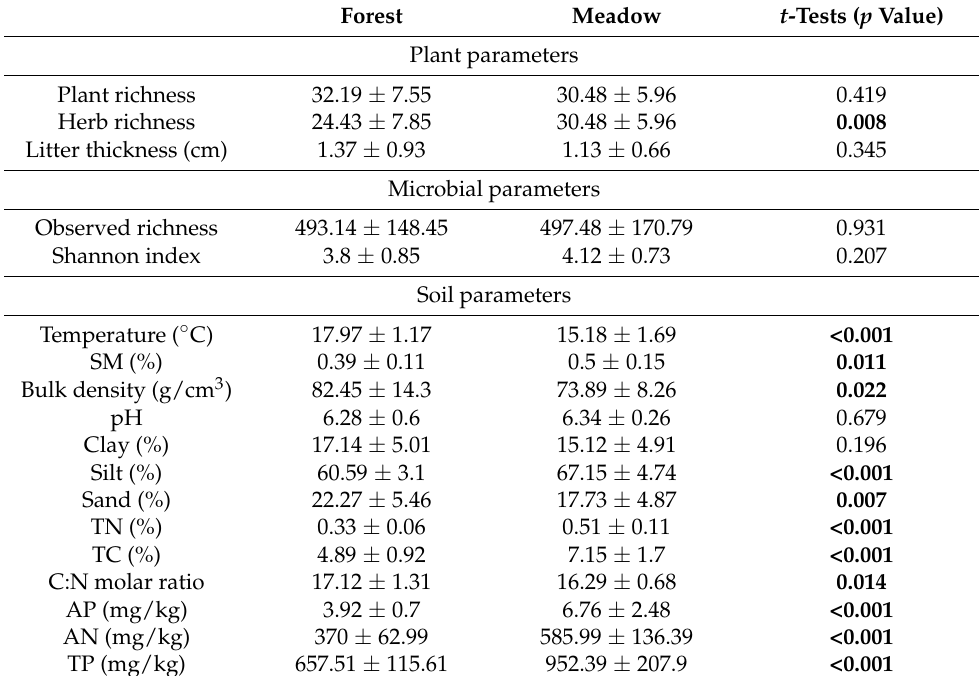
Table 1. Summary of biotic and abiotic parameters of montane forest and subalpine meadow and significance of differences based on t